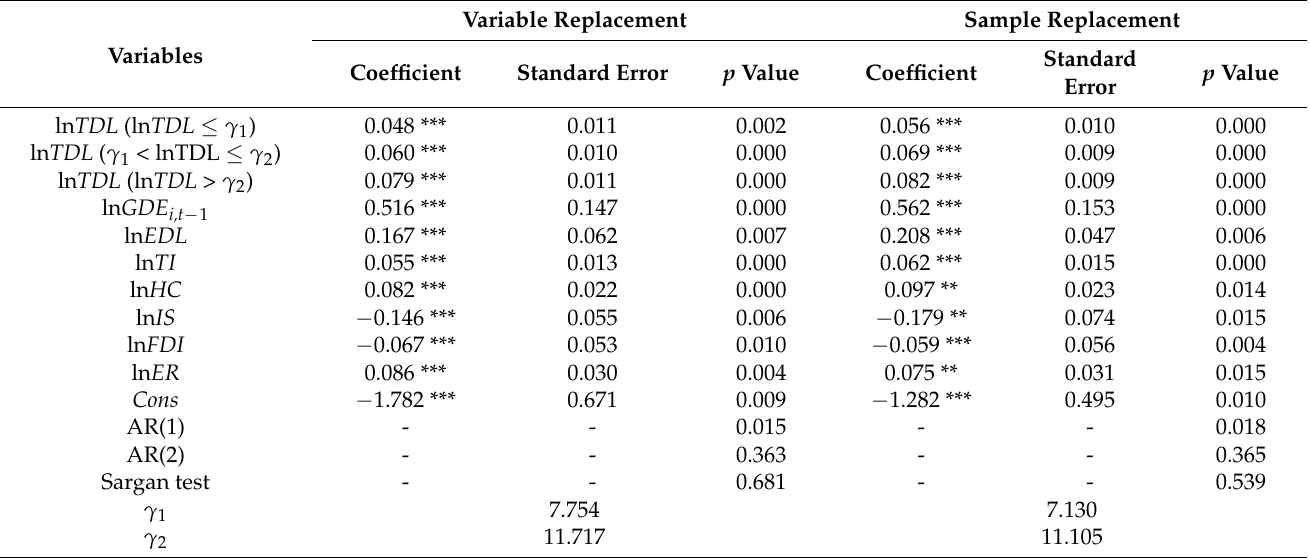
Table 8. Robustness test of estimation results of dynamic panel threshold regression